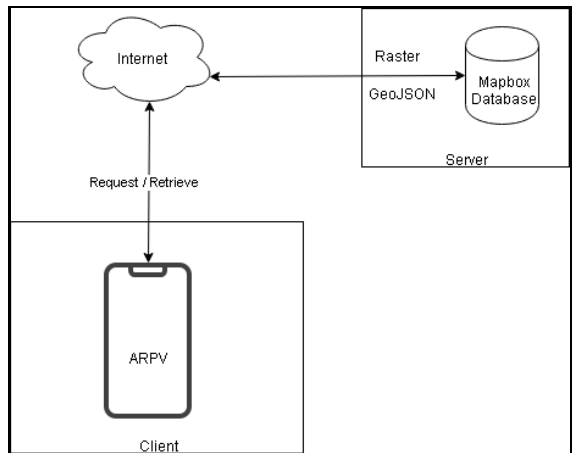
Figure 1. ARPV system architecture